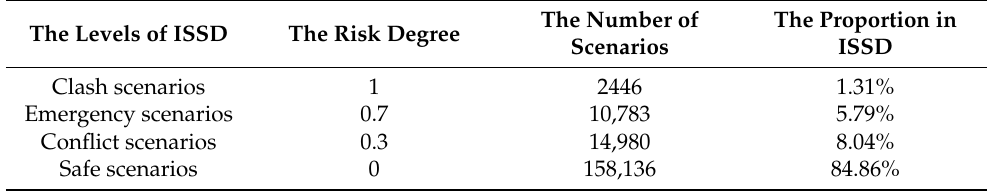
Table 8. The risk degree and the number of scenarios corresponding to different levels of ISSD. The Levels of ISSD The Risk Degree